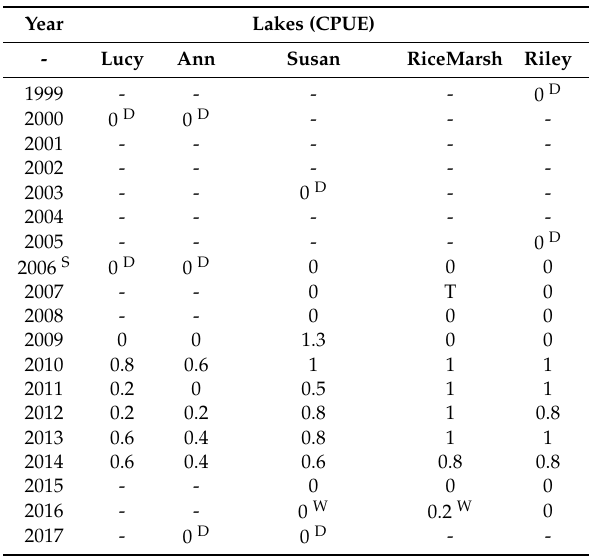
Table 7. Trap-net captures of YOY carp (CPUE) in the Riley Chain of Lakes.